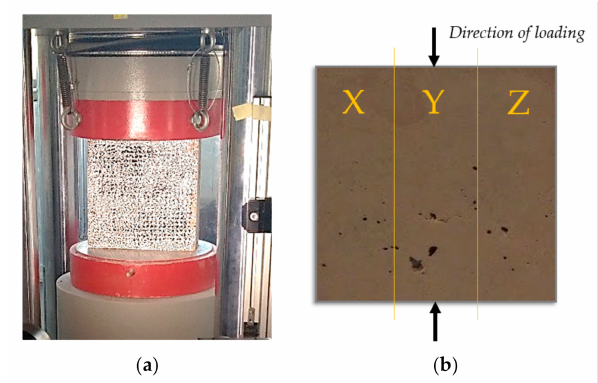
Figure 3. Loading of the plate ( a ); how the loaded plate was cut into 3 pieces ( b ).